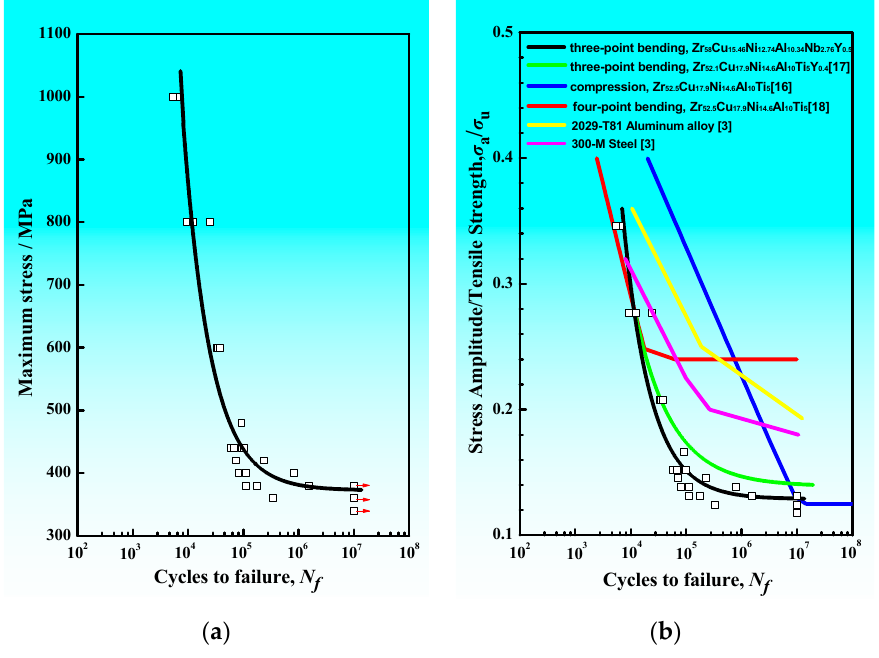
Figure 4. Stress–life (S-N) fatigue data for several alloys. ( a ) Maximum stress (MPa) versus N f ; ( b ) Stress amplitude/tensile strength ( σ a / σ u ).